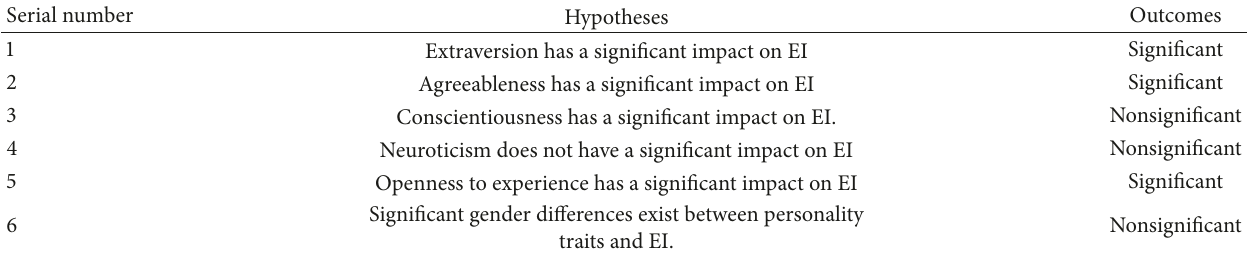
Table 9: Summary of hypotheses.